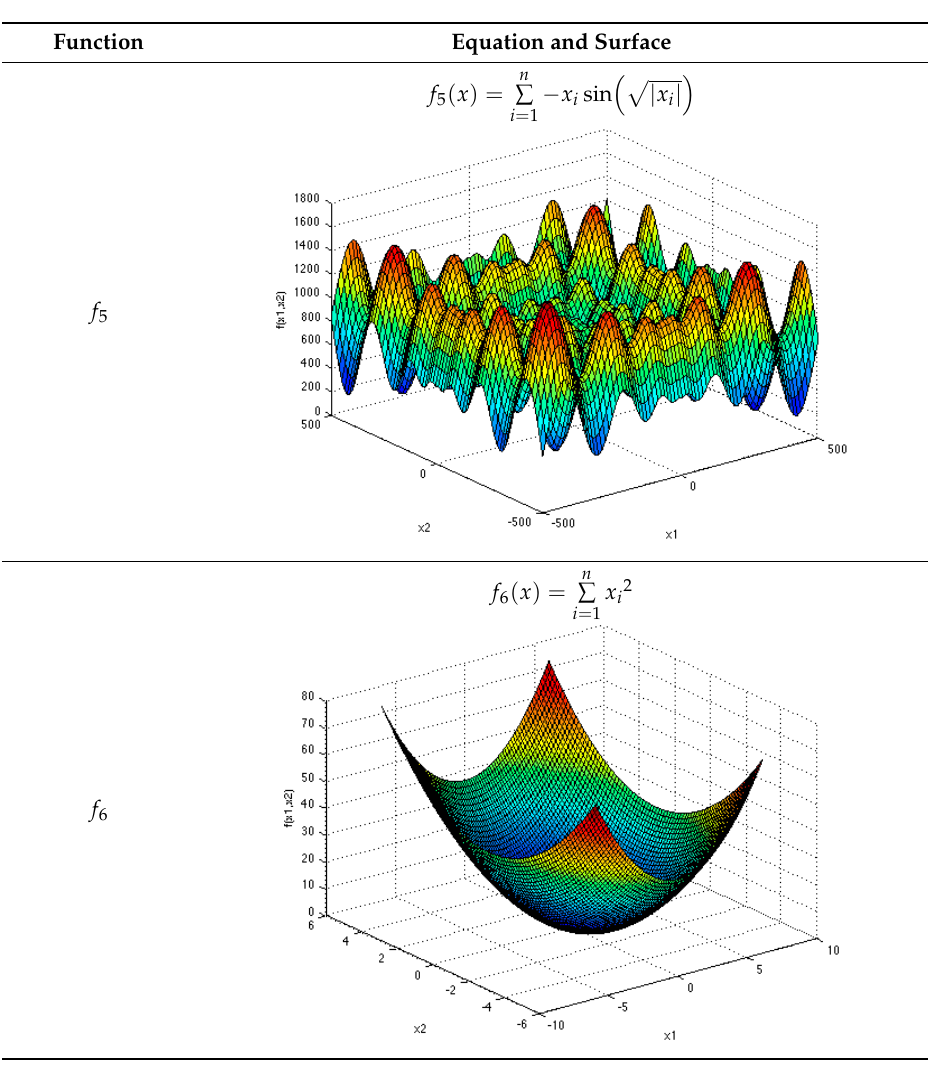
Table 5. Equations and plots of benchmark functions with optima different from zero. Function